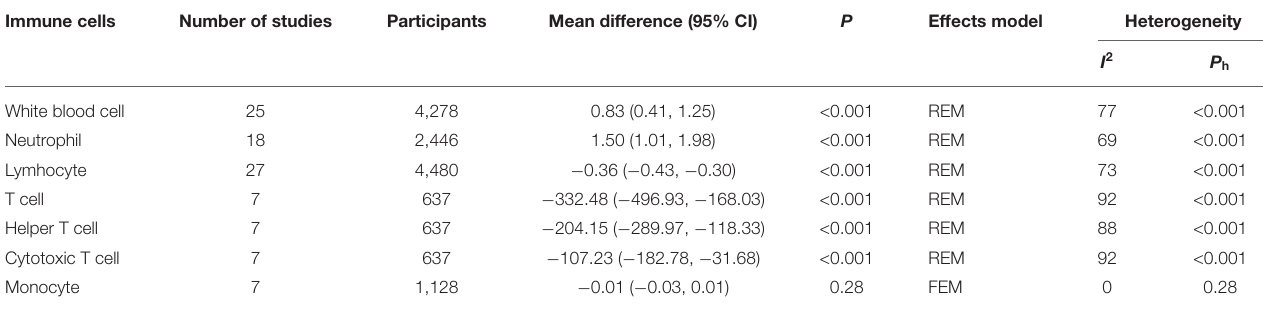
TABLE 2 | The association between immune cells and disease severity in patients with COVID-19. Immune